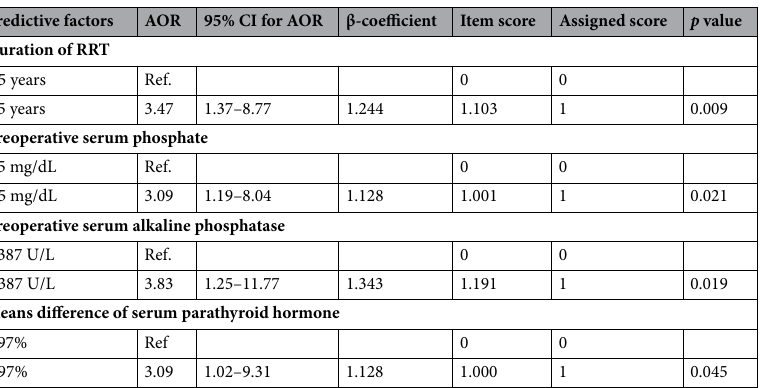
Table 3. Multivariate logistic regression analysis with coefficient values of each factor and their assigned score.